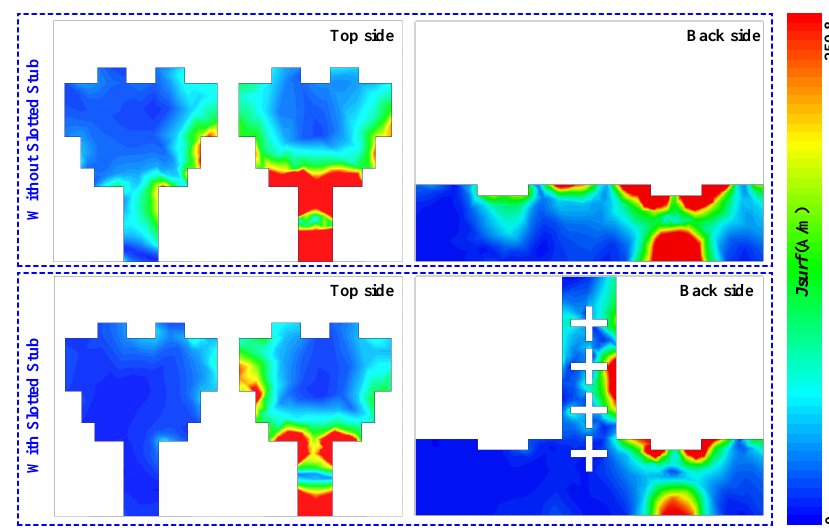
Figure 9. Surface current distribution with and without slotted stub at 10 GHz.